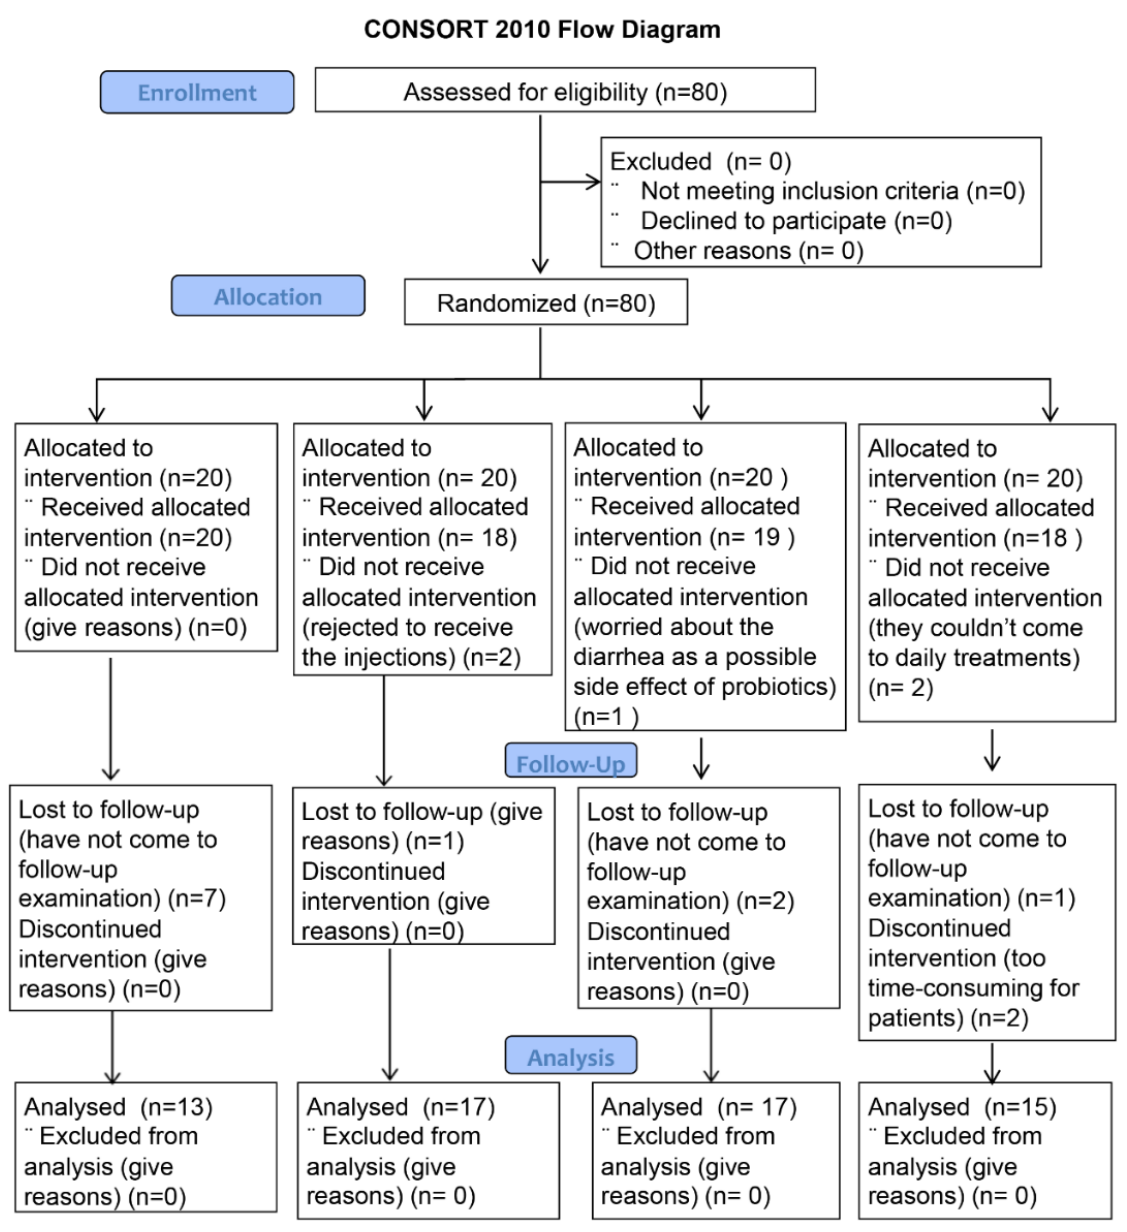
Figure 2. Flow chart of the enrollment of participants. Table 3. Age and gender distribution among the different therapeutic groups ( p > 0.05, Kruskal– Wallis test).